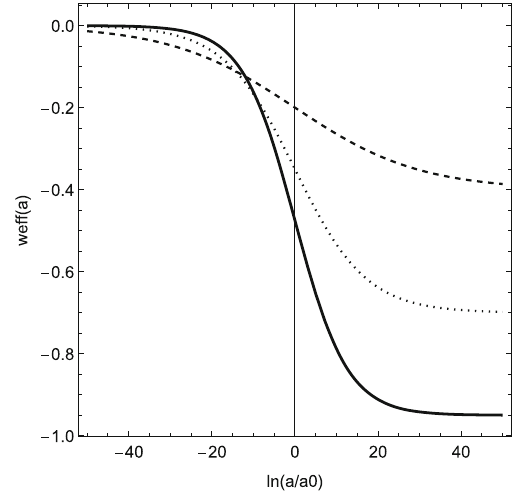
Fig. 2 Qualitative evolution for the equation of state evolution w ( a ) for the NGCG of our consideration. Plot is for ¯ A = 1 and ef f α = 1. Solid line is for ω = − 0 . 95 , dotted line is for ω de and dashed line is for ω de = − 0 .